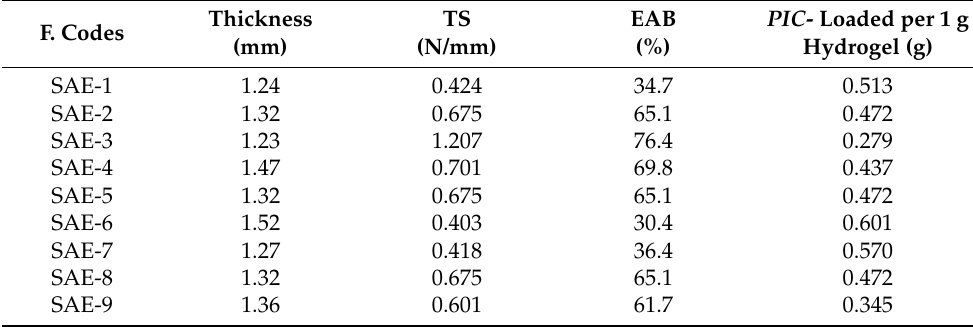
Table 1. The mechanical properties and drug loading of SA-g-AMPS